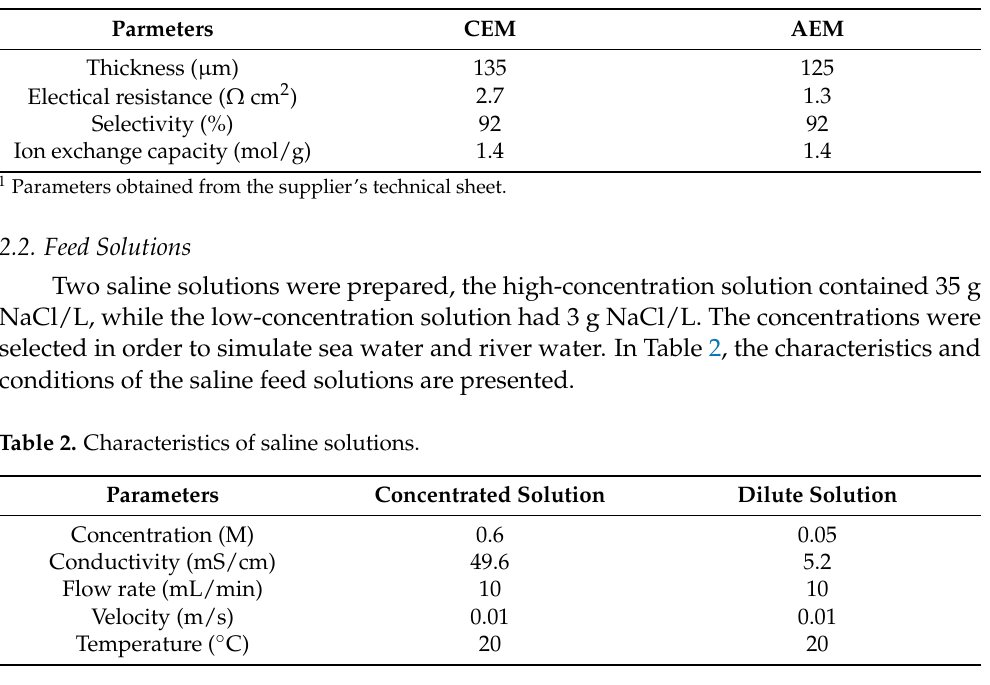
Table 1. Main properties of Fujifilm Type 1 membranes 1 .